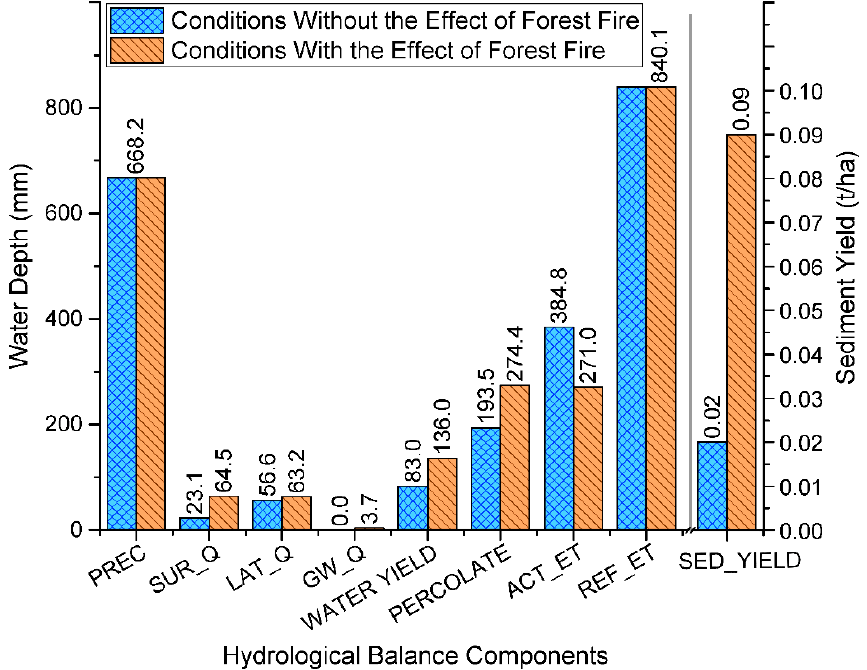
based on the model results for the pre-fire and the post-fire periods is presented in Table 4 and a graphical representation of the average annual values of the simulated water bal- Figure 5. Monthly rainfall and runoff depth temporal distribution, observed and simulated for the Figure 5. Monthly rainfall and runoff depth temporal distribution, observed and simulated for the two examined scenarios. ance components is provided in Figure 6. two examined scenarios.